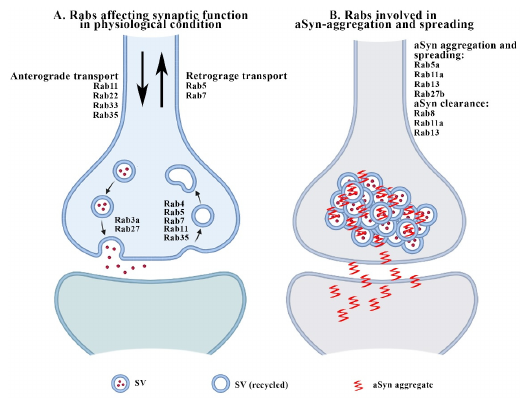
Figure 1. The cartoon summarizes the Rabs involved in the modulation of synaptic function in physiological conditions ( A ) and in aSyn aggregation and spreading ( B ). 3. Major Rab Alterations in PD and Other Forms of Parkinsonism: A Focus on aSyn-, GBA1- and LRRK2-Associated Synaptopathy